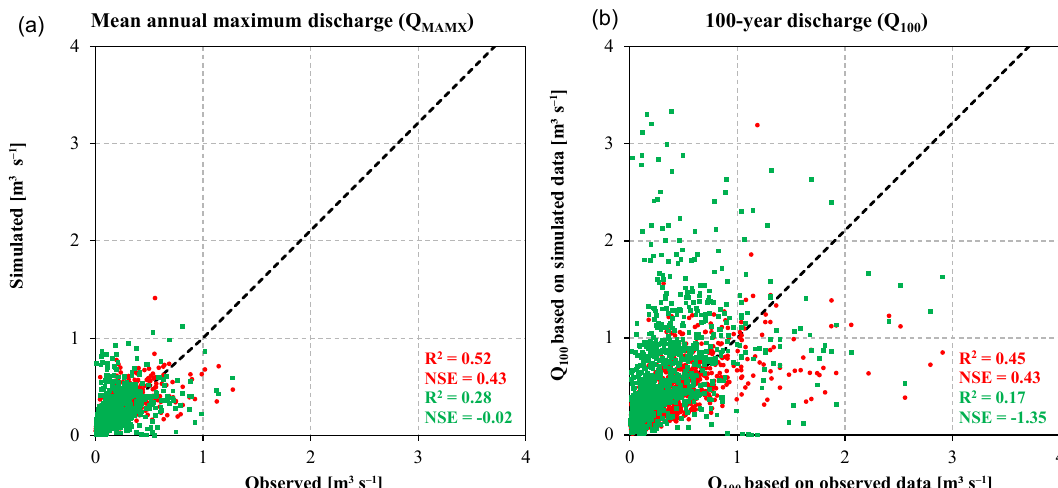
Figure 10. As Fig. 9, but for specific discharge, i.e. divided by catchment